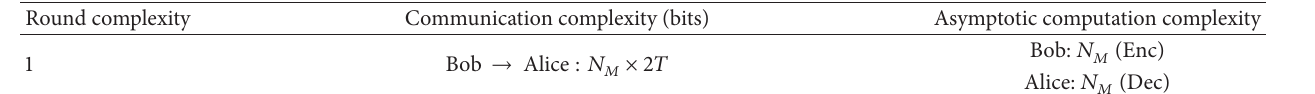
Table 2: Complexity of protocol City block